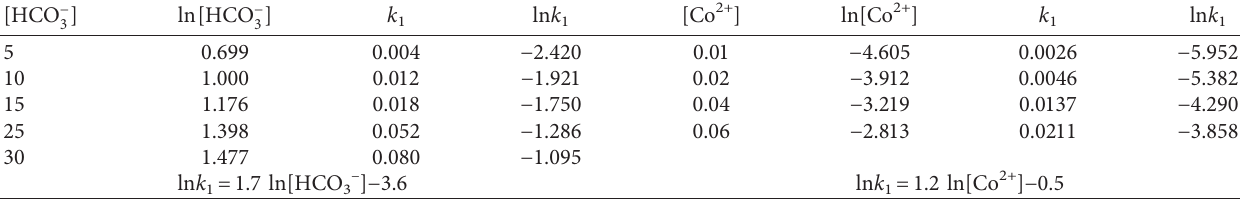
Figure 7: Dependence of (a) RB19 concentration and (b)ln ( Co / C O , and pH 8. H 2 2 Table 2: Experimental data for determining the orders of HCO 3– and Co 2+ in RB19 degradation. [HCO − 3